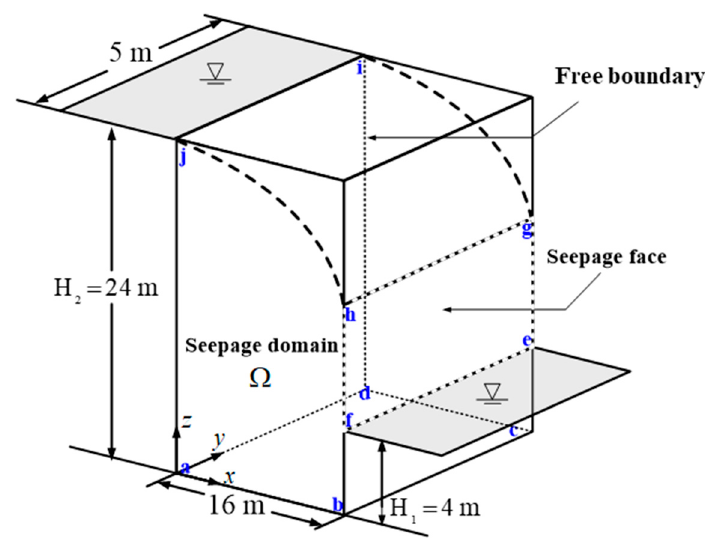
Figure 1. Three-dimensional nonlinear free surface flow through a dam.